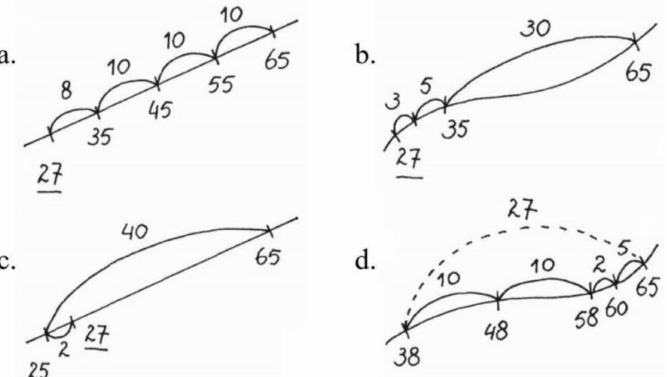
Figure 6. Calculating 65 − 38 on the empty number line by doing ( a ) 65 – 10 − 10 – 10 – 8, ( b ) 65 – 30 – 5 – 3, ( c ) 65 – 40 + 2 and ( d ) 38 + . . . = 65 in Proeve [40] (p. 54–55).